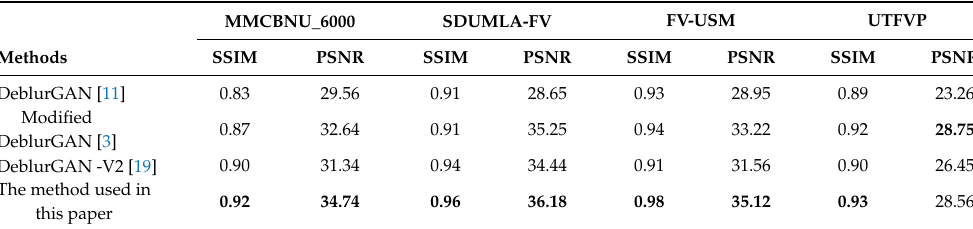
Table 4. PSNR (dB) and SSIM of various deblurring methods on the different public datasets. MMCBNU_6000 SDUMLA-FV FV-USM UTFVP Methods